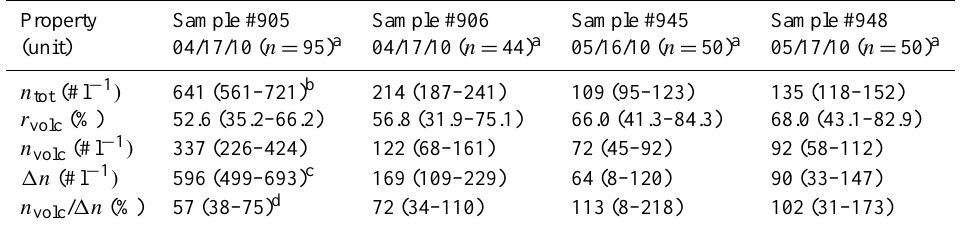
Table 3. Estimated atmospheric number concentrations of volcanic IN based on particle analysis versus peak enhancement of IN above background in volcanic plume.